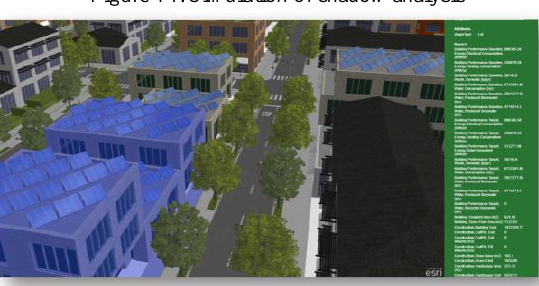
Figure 15. Reports for the selected